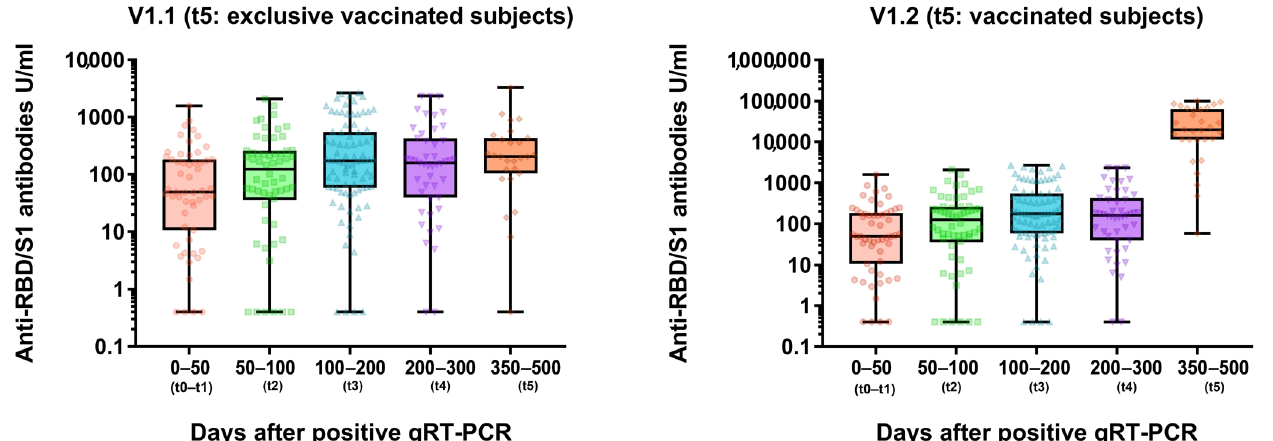
Figure 3. Longitudinal anti-SARS-CoV-2-anti-RBD/S1 dynamic (U/mL) in recovered COVID-19 subjects. V1.1 cohort of t5 appointment includes only unvaccinated subjects ( left figure). Vaccinated subjects were included in the V1.2 cohort at t5 ( right figure). Table 4. Comparison of SARS-CoV-2 ab of COVID-19 recovered subjects after 6 and 12 months (all subjects).